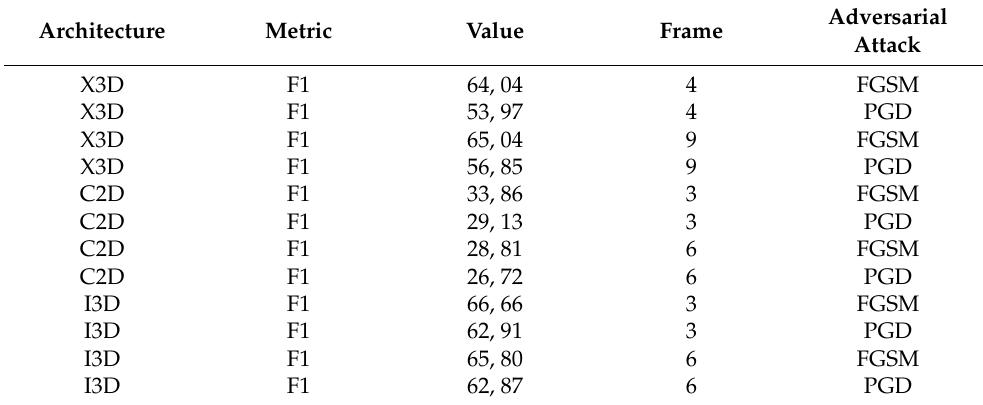
f-measure results